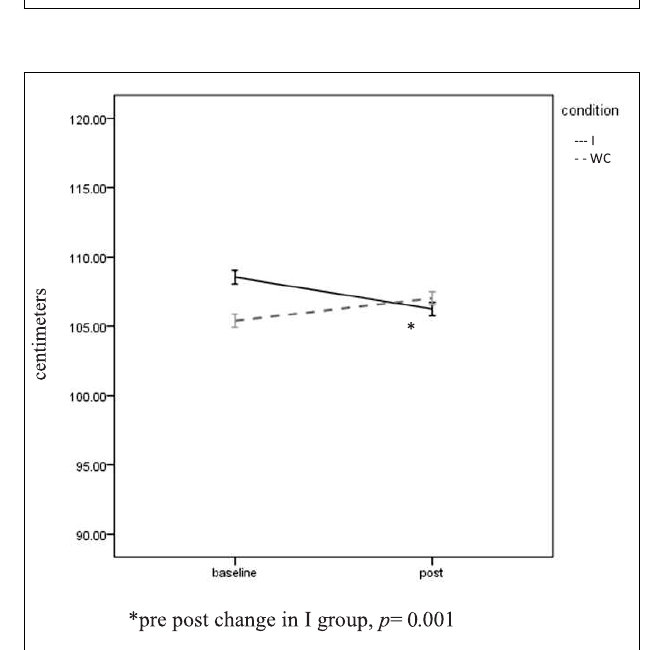
FIGURE 3 | Intervention pedometer steps . *Significant increase from baseline.